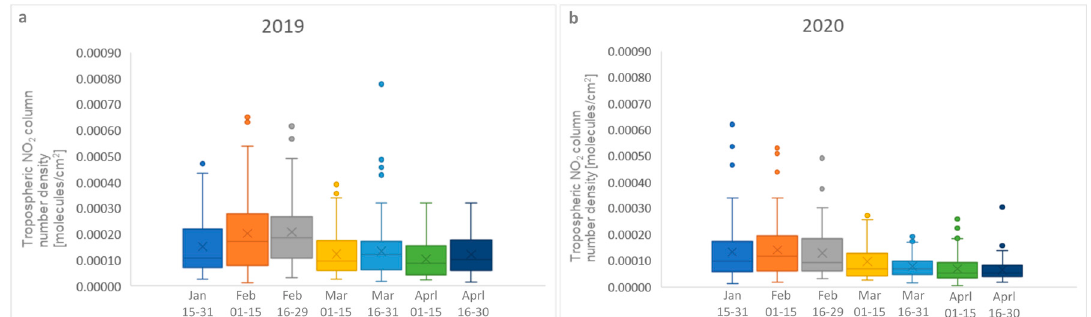
Figure 7. Comparative dynamics of NO 2 daily values for the period between 15 January and 30 April, for different European cities, based on clear-sky TROPOMI data in 2019 and 2020 ( a – d ) and ground- based measurements in 2020 ( e – h ).